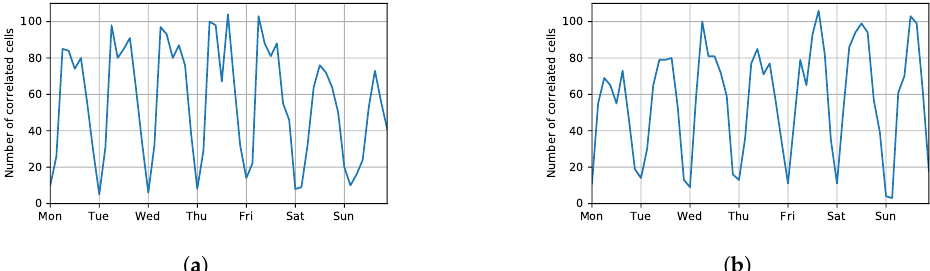
Figure 9. CS-D strategy: Number of correlated cells in different temporal contexts. ( a ) cell Catering and entertainment ; ( b ) cell Business